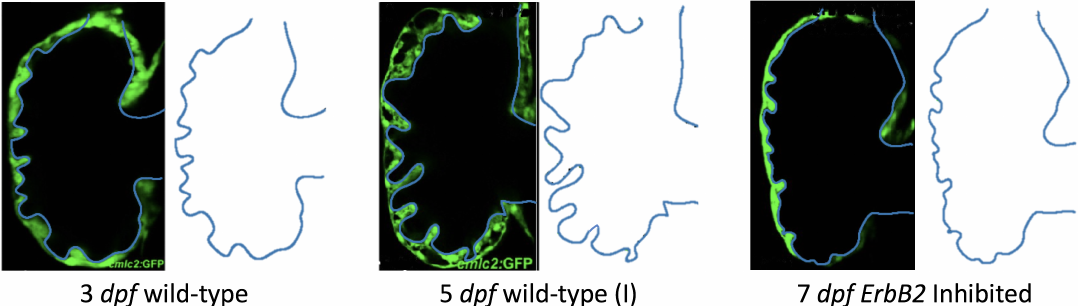
Figure 2. The extracted geometries from trabeculated ventricles at different stages of development from Liu et al. [21]. There are two wild-type (WT) zebrafish cases shown (3 dpf and 5 dpf (I)) as well as the geometry taken from an ErbB2 -inhibited zebrafish at 7